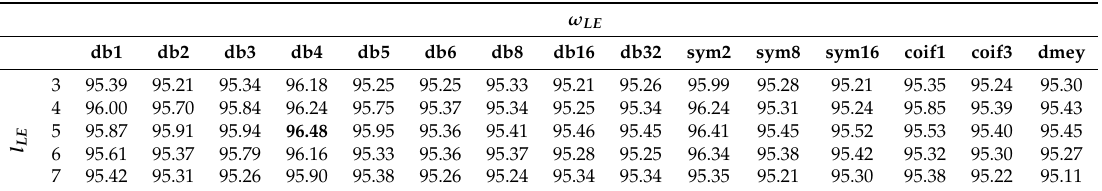
Table 21. The accuracy (%) of two class sleep stage classification with different ω LE and l LE under AASM standard.